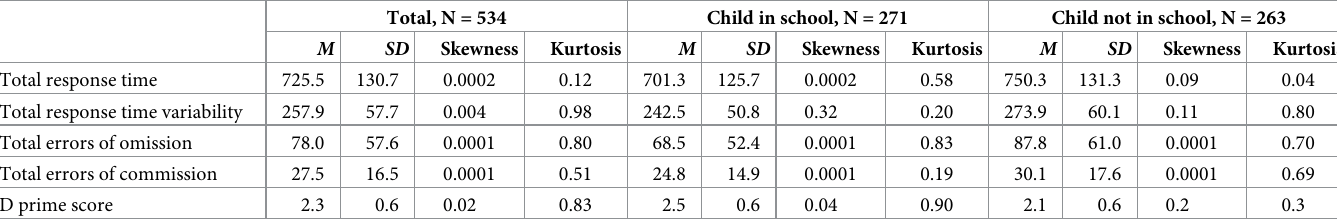
Table 3. Population parameters of performance scores in the d2 Sustained-Attention Test.